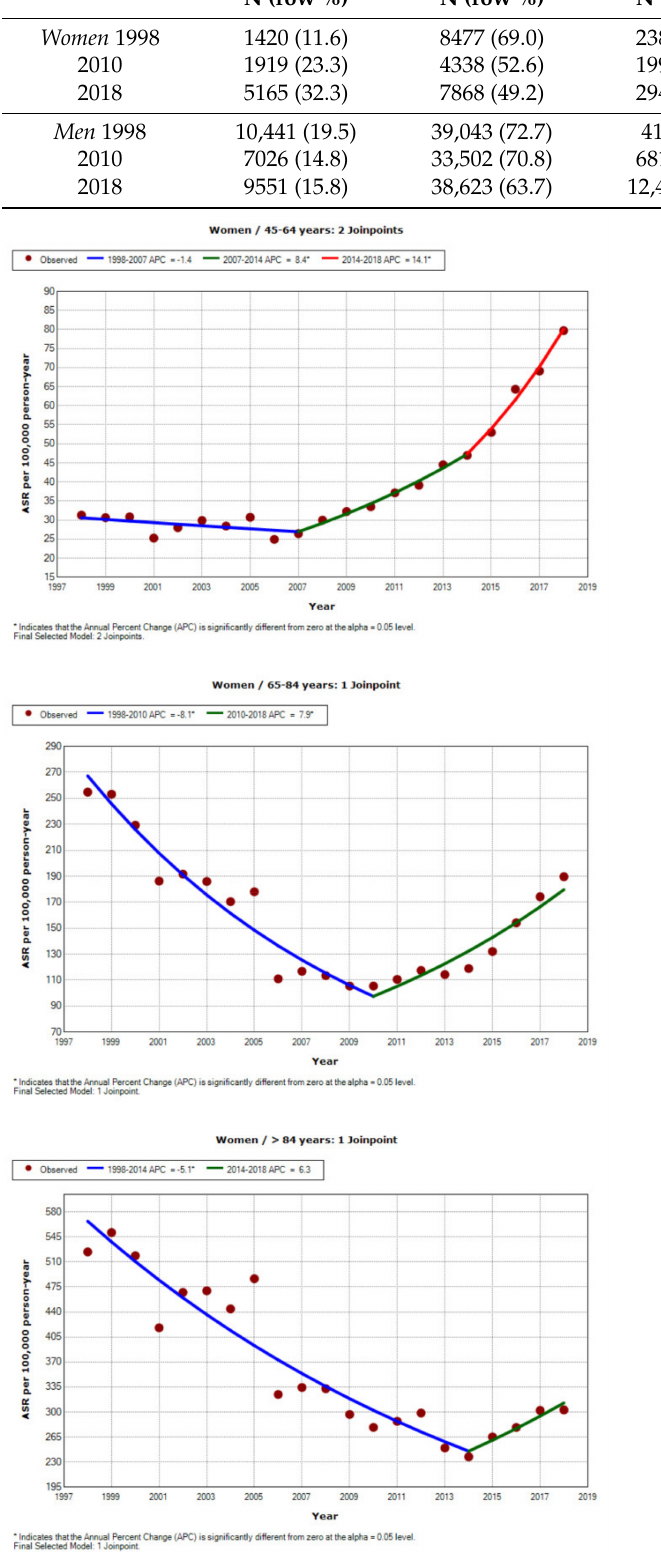
Figure 1. Joinpoint regression analysis of trends in hospital admission due to COPD in women Spain from 1998 to 2018, by age